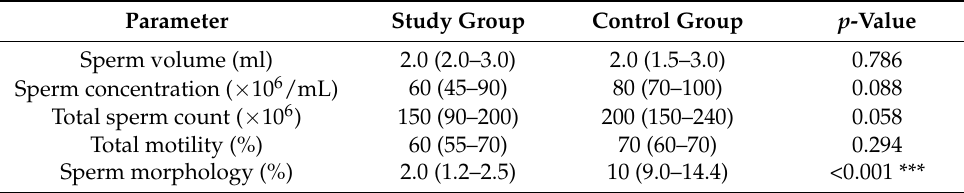
Table 1. Baseline semen parameters of the samples used in the IVF/ICSI